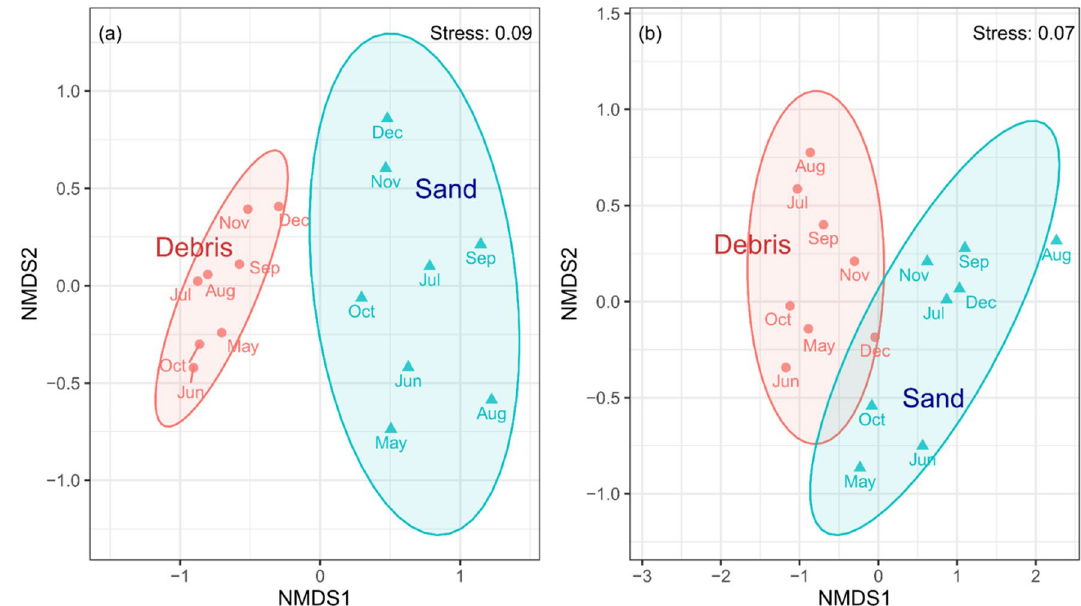
Figure 4. Non-metric multidimensional scaling with Bray–Curtis distance based on relative abundances of all bacterial Genera: ( a ) and 84 pathogenic bacterial Genera; ( b ) in debris (circle) and sand under the debris (triangle) from May to December. Ellipses surrounding each environmental group indicate 90% confidence